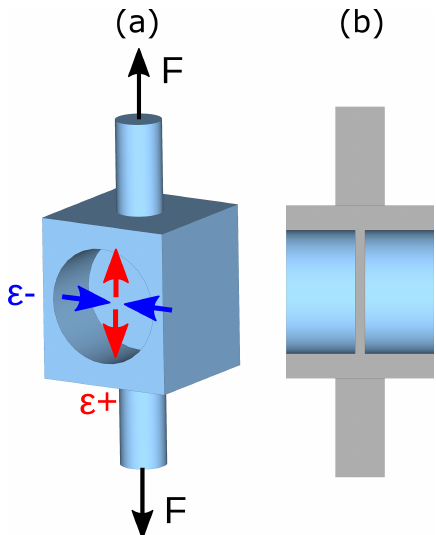
Figure 8. (a) Model of a tension/compression force transducer with the applied force and resulting strains on the membrane surface. (b) A sectional view of the transducer shows the position and thickness of the